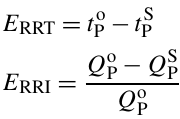
Figure 10. Dependency of the standard deviation of the Nash–Sutcliffe efficiency sample, σ N data in the experimental scenarios 1 to 9 for the considered flood events in the three catchments: Brue (upper row), Sieve (middle row), and Alzette (bottom